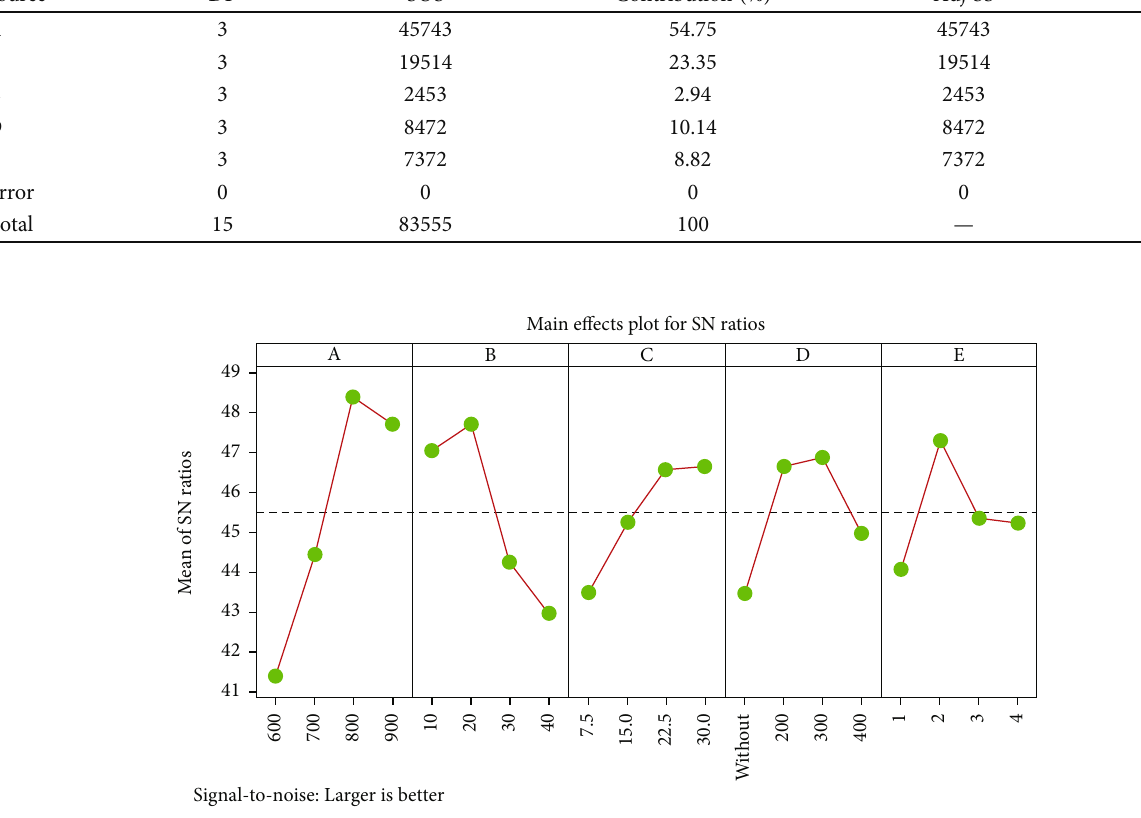
Figure 1: The iodine values of adsorptions based on various input factors.